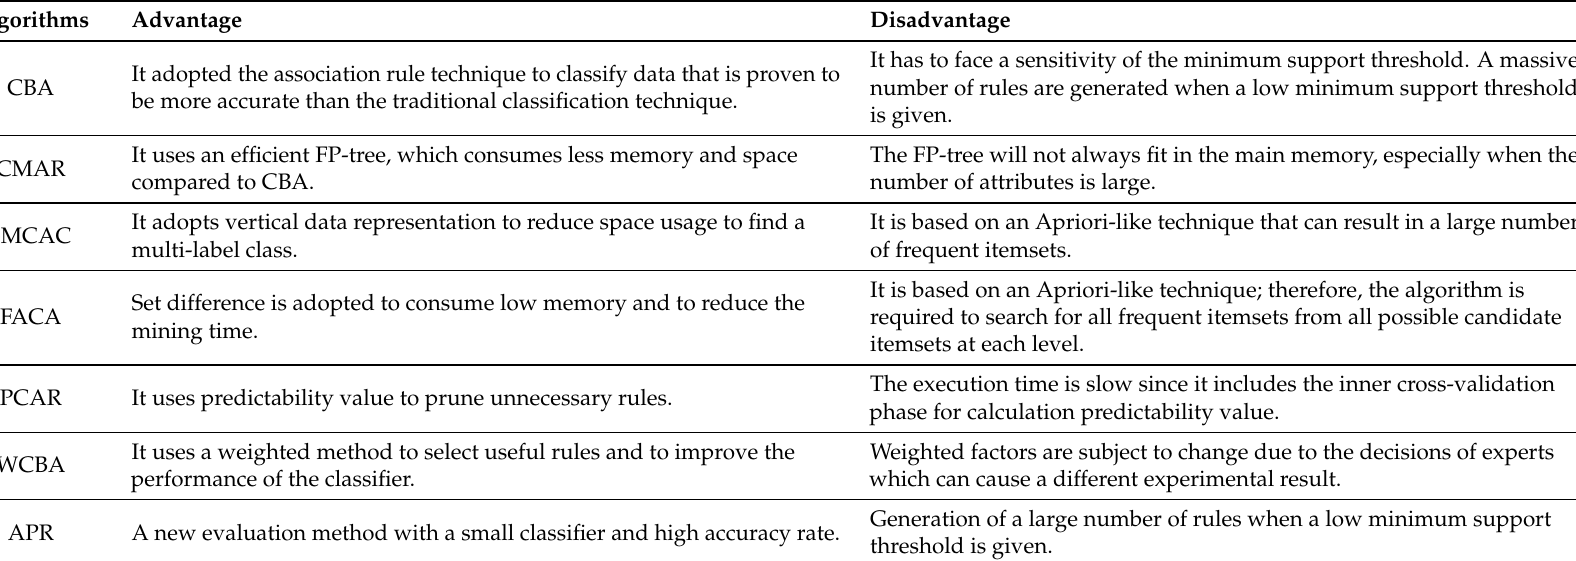
Table 1. Advantages and disadvantages of Associative classification (AC)